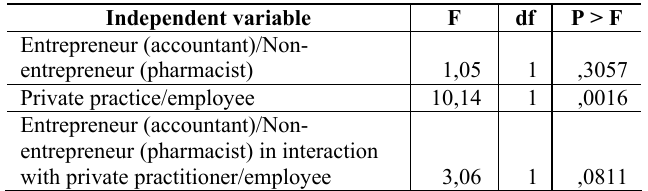
Table 3: Results of analysis of variance with the entrepreneurial self-Esteem sub-scale as dependent